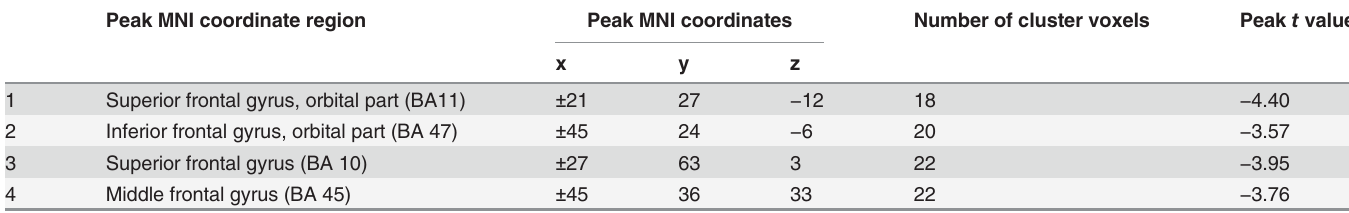
Table 1. Regions showing group differences in voxel-mirrored homotopic connectivity. Peak MNI coordinate region Peak MNI coordinates Number of cluster voxels Peak t value x y Superior frontal gyrus, orbital part (BA11) ± 21 Inferior frontal gyrus, orbital part (BA 47) Superior frontal gyrus (BA